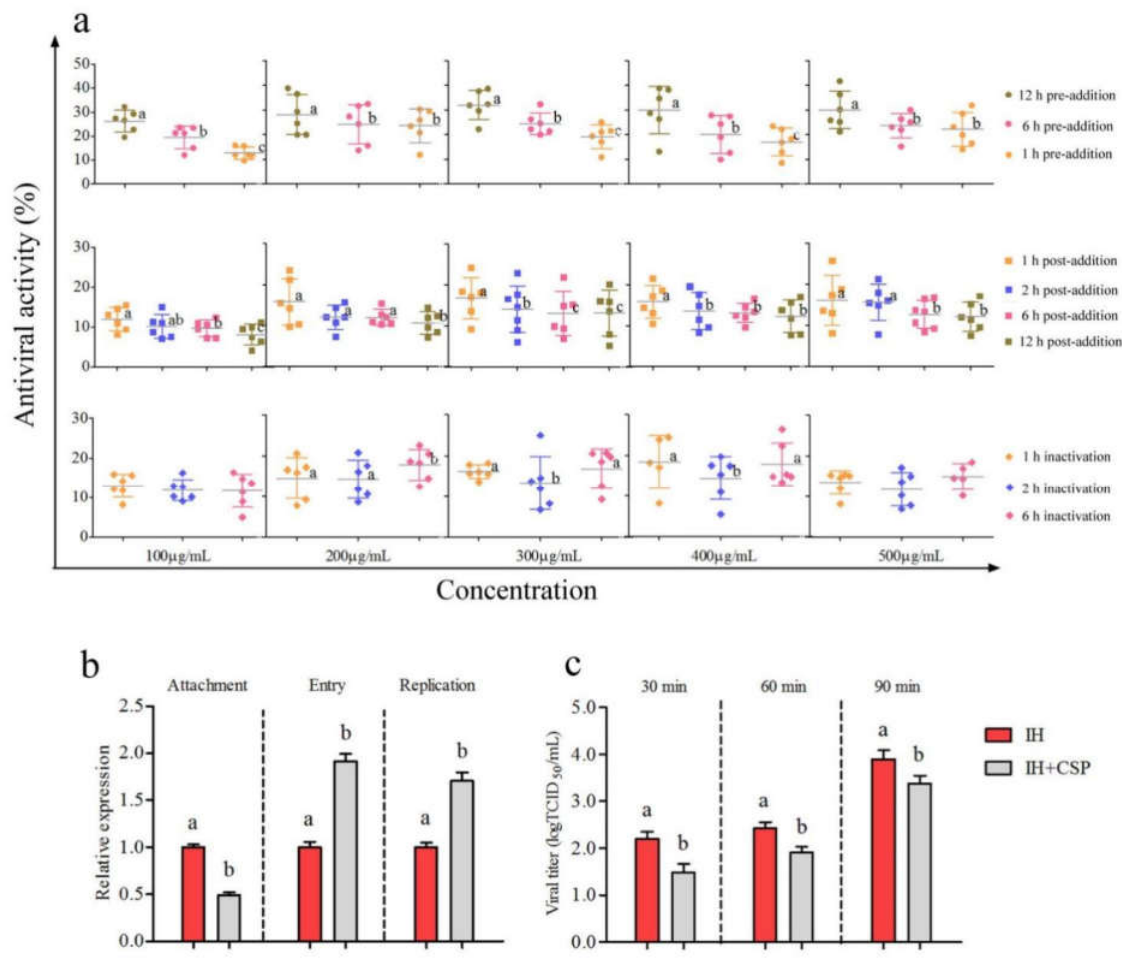
Figure 2. The antiviral activity and actions of CSP on IHNV. ( a ) The antiviral activity of CSP with different concentrations on IHNV under the pre-addition, post-addition, and inactivated treatments. ( b ) The changes of relative expression levels of IHNV-L gene in the viral attachment, entry, and replication processes, respectively. ( c ) The determination of the viral titers during the viral release process. Different letters indicate statistical significance, p < 0.05.